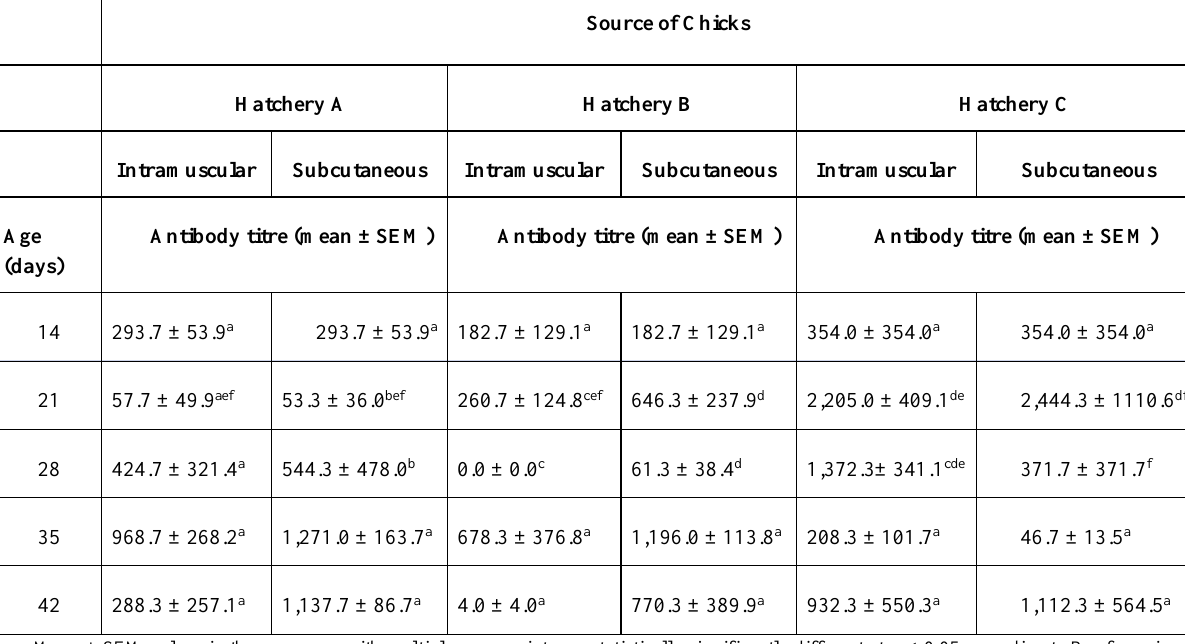
Table 3. Antibody responses of ISA brown pullets from three commercial hatcheries to 0.2 ml dose-regime of inactivated avian influenza H5 vaccine administered at 14 and 28 days of age via either intramuscular or subcutaneous routes.